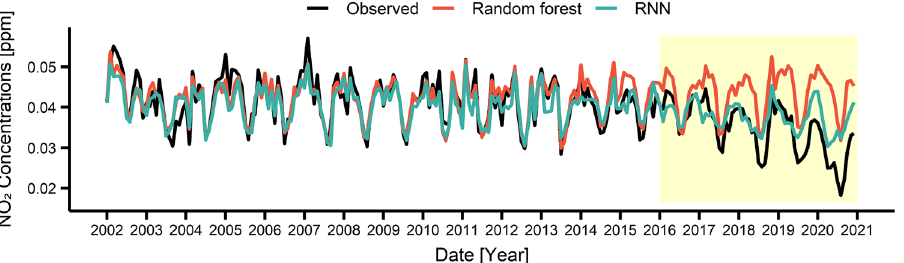
Figure 4. Monthly concentrations of observed and predicted values by using RNN and RF for NO 2 . The area shaded in yellow showed the period when the Euro 6 was applied.